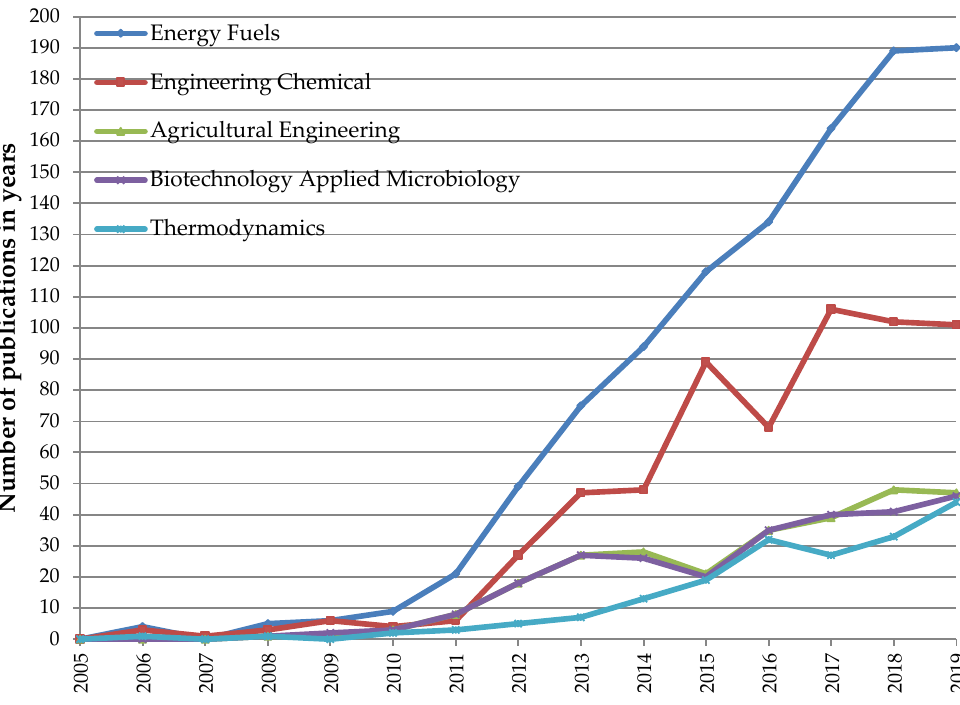
Figure 6. Number of articles in years indexed in WoS-CC in relation to the Web of Science category—2005–2019.